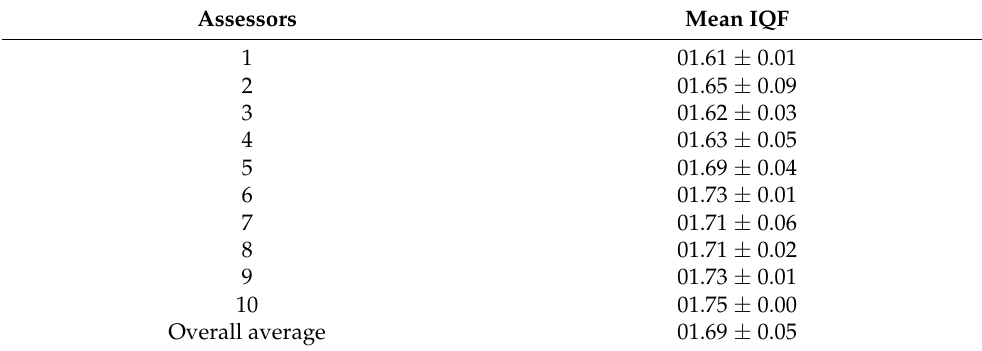
Table 2. The mean values of image quality factor (IQF) for the ten assessors and overall mean IQF